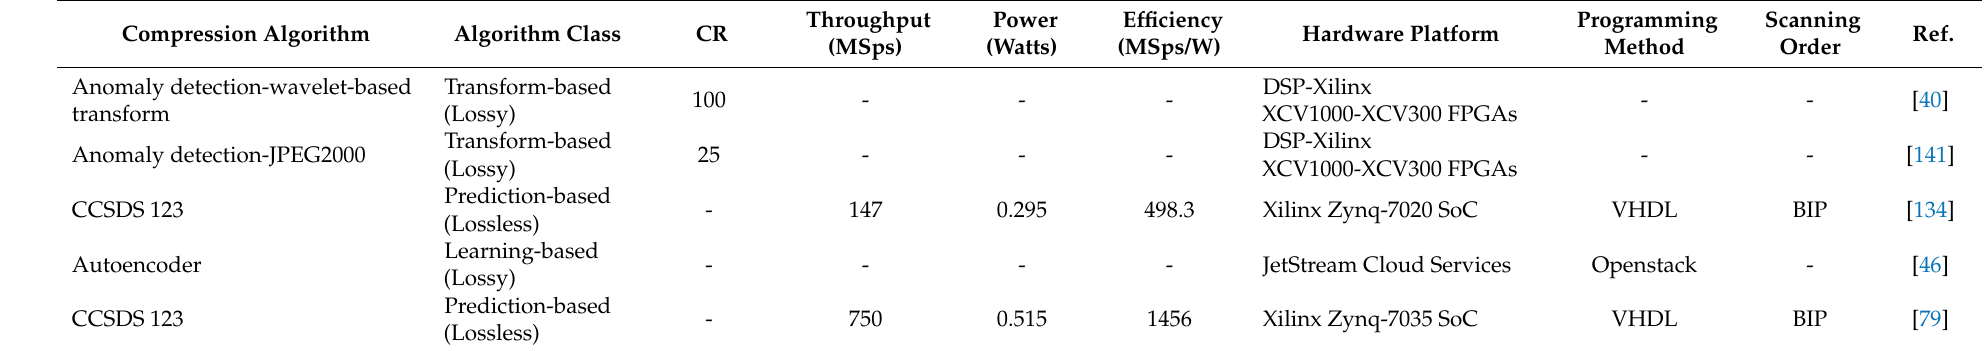
Table 16. Comparison of the proposed compression system validated using the Hyperion